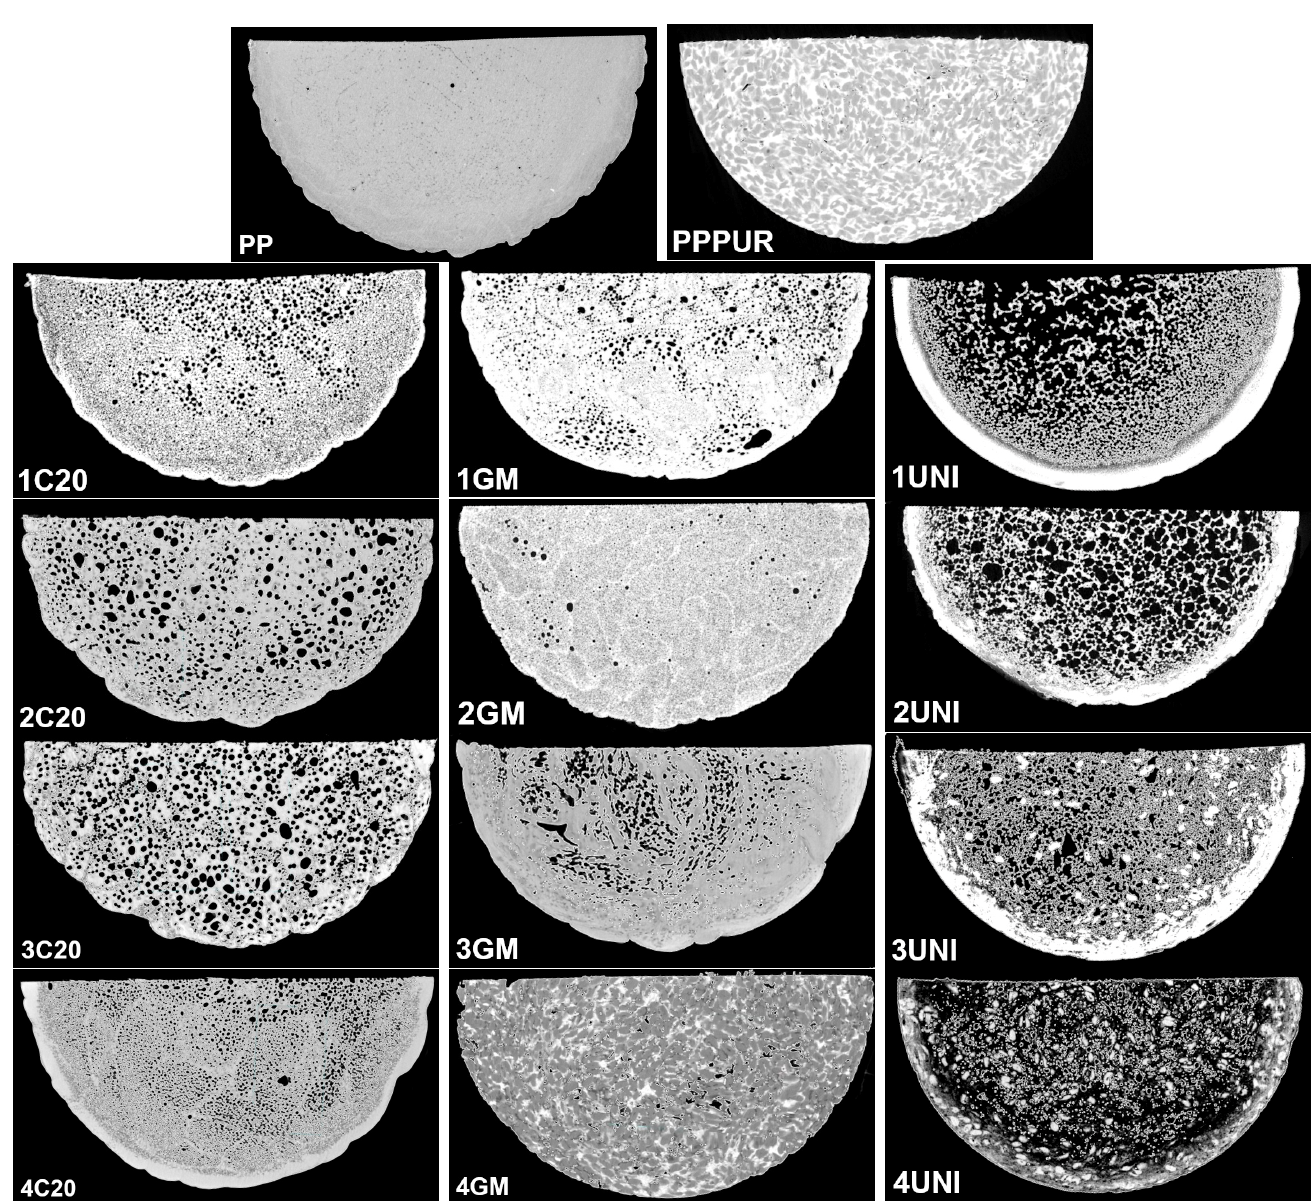
Figure 3. Scans obtained during µCT analysis of prepared